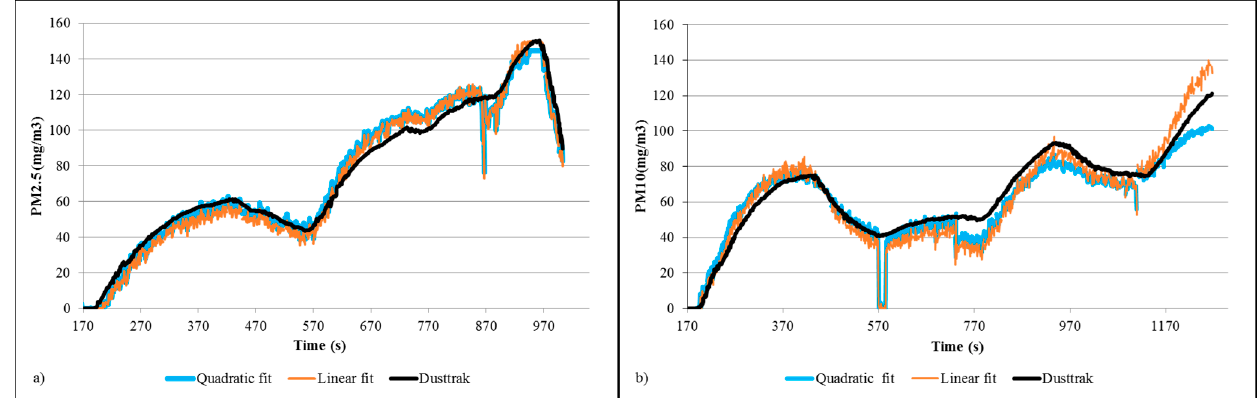
Figure 8. Linear and quadratic linear fit for raw SHARP values of ( a ) PM2.5 and ( b ) PM10 particle